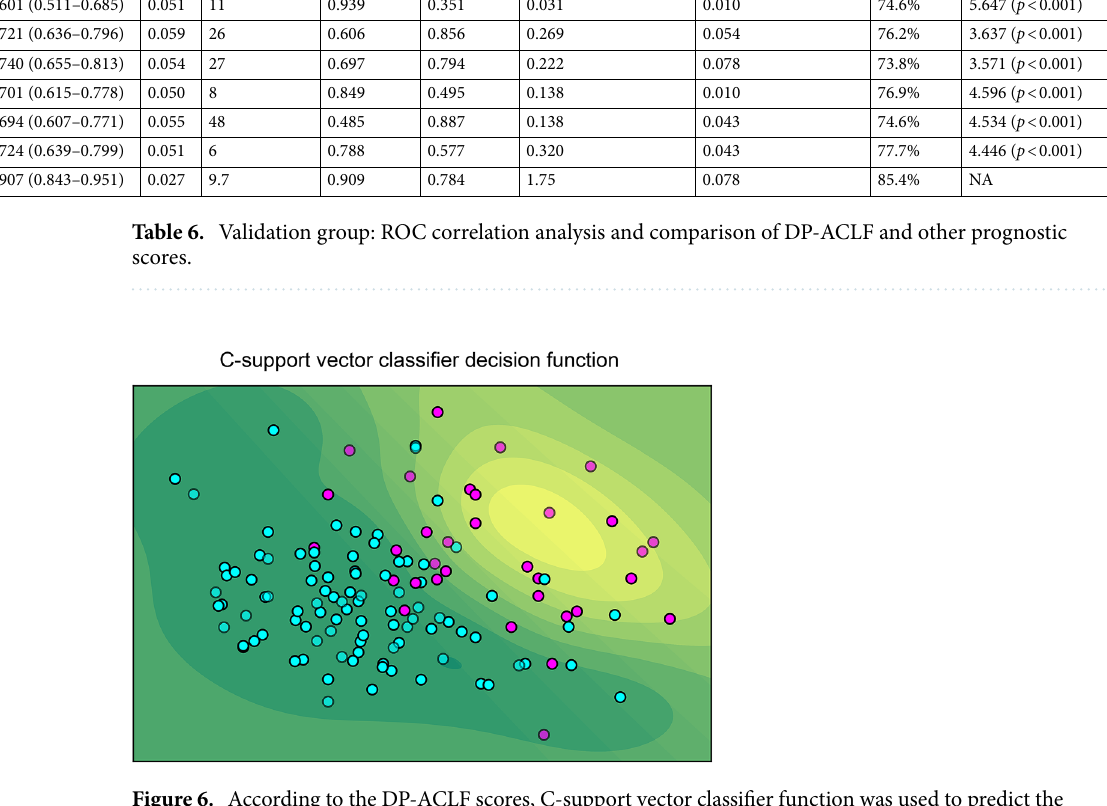
Figure 6. According to the DP-ACLF scores, C-support vector classifier function was used to predict the decision function value of each case in the validation group. Python software with matplotlib and sklearn packages was used to show that 90 cases of survivors (blue) (survival time ≥ 90 days) and 21 cases of non- survivors (red) (survival time < 90 days) were distributed in the green and yellow areas, respectively. The darker the color of the region in which the dots were located, the more accurate the prediction